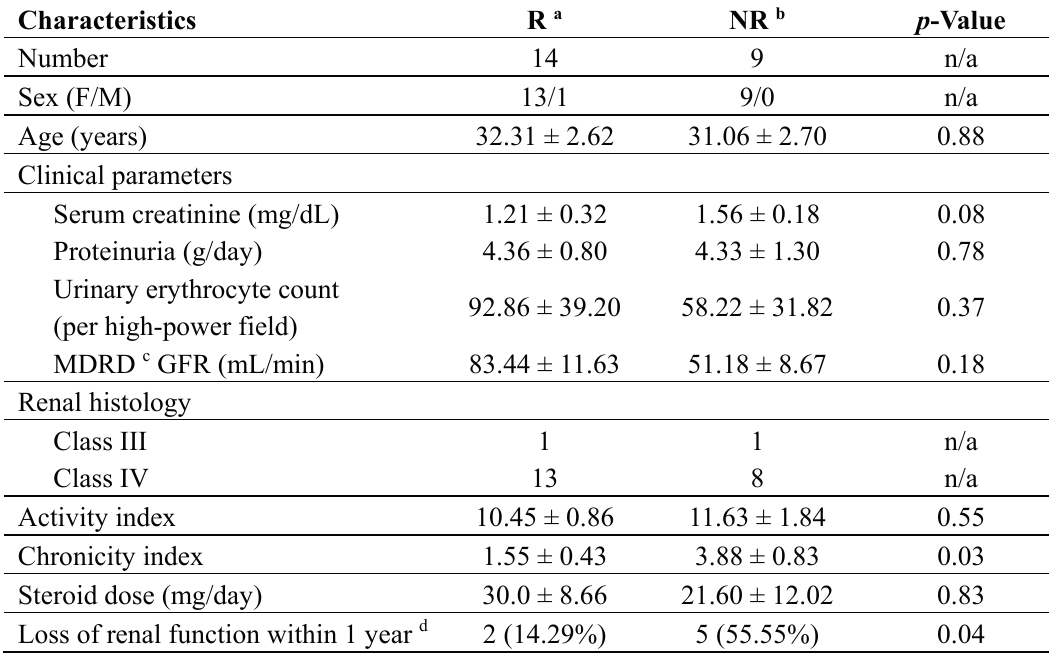
Table 1. Characteristics of the patients in the training set.